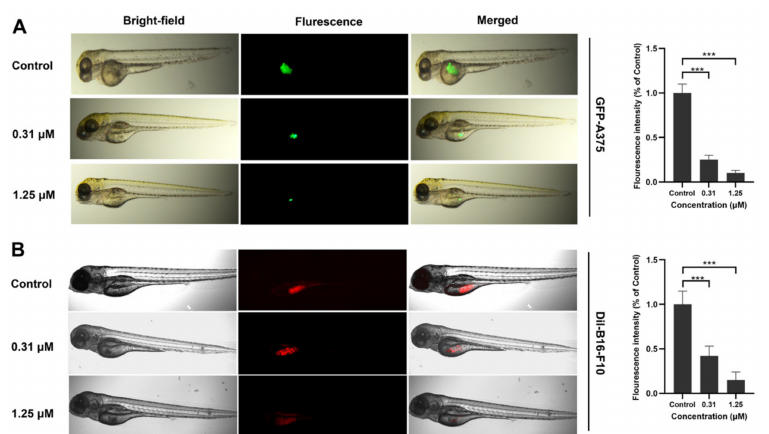
Figure 7. Antitumor evaluation of IR-817 in zebrafish tumor model. ( A ) The GFP-A375 tumor fluorescence changes were photographed with a stereological fluorescence microscope, and statistical analysis of tumor fluorescence intensity in the right (mean ± SD, n = 5). ( B ) The Dil-B16-F10 tumor fluorescence change was photographed with confocal microscopy, and statistical analysis of tumor fluorescence intensity in the right (mean ± SD, n = 5). *** p < 0.001 compared with the control group.